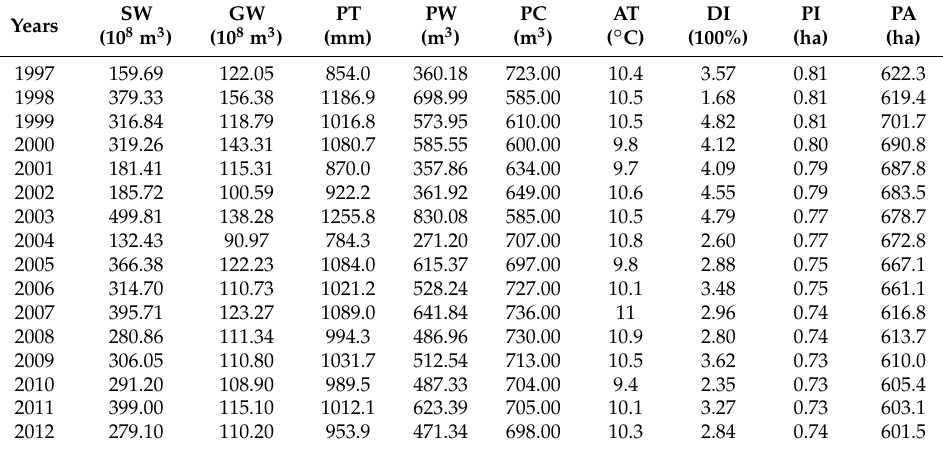
Table 2. Data aggregation (resource factors) of WC/$10 4 GDP influencing factors in Jiangsu from 1997 to